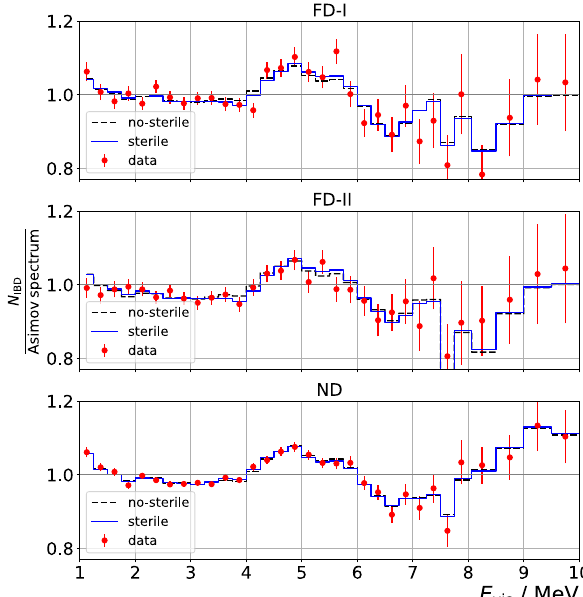
Fig. 10 Experimental residuals for the three consistently fitted data sets FD-I, FD-II, and ND. The data are normalized to the nominal reac- tor expectation [38] adapted to the Double Chooz reactors including conventional oscillations with parameters taken from an independent measurement [12]. The experimental data are plotted as red dots. The global best fit is shown as a solid line while for comparison the best-fit null hypothesis is shown as a dashed line. As the fit optimizes system- atic uncertainties to the data, only statistical error bars are displayed